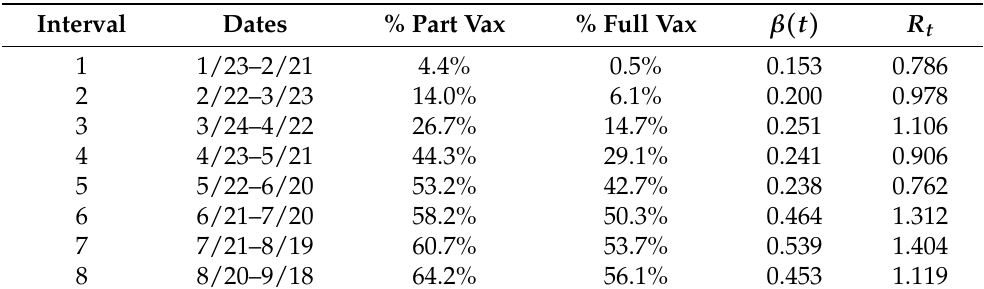
Table 3. Vaccination level, effective transmission rate, and the effective reproduction number for the spread of COVID-19 in Virginia over the period 23 January through 18 September 2021.